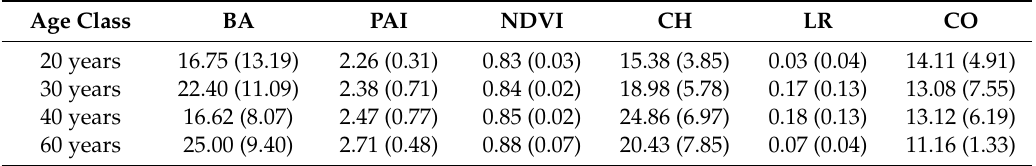
Figure 3. Linear Discriminant Analysis (LDA) for the different forest age classes (i.e., 20, 30, 40, and 60 years old) and forest structural characteristics (tree basal area: BA; percentage of canopy openness; CO; plant area index (PAI); canopy height: CH; and Normalized Difference Vegetation Index: NDVI). Axis 1 (Can1) explains 74.5% of the variance and Axis 2 (Can2) explains 21.5%. Table 1. Mean (SD) forest structural characteristics recorded for the forest age classes by [29]. CO: the percentage of canopy openness, PAI: plant area index, CH: canopy height, BA: tree basal area, LR: the liana-to-tree ratio, and the Normalized Difference Vegetation Index (NDVI).